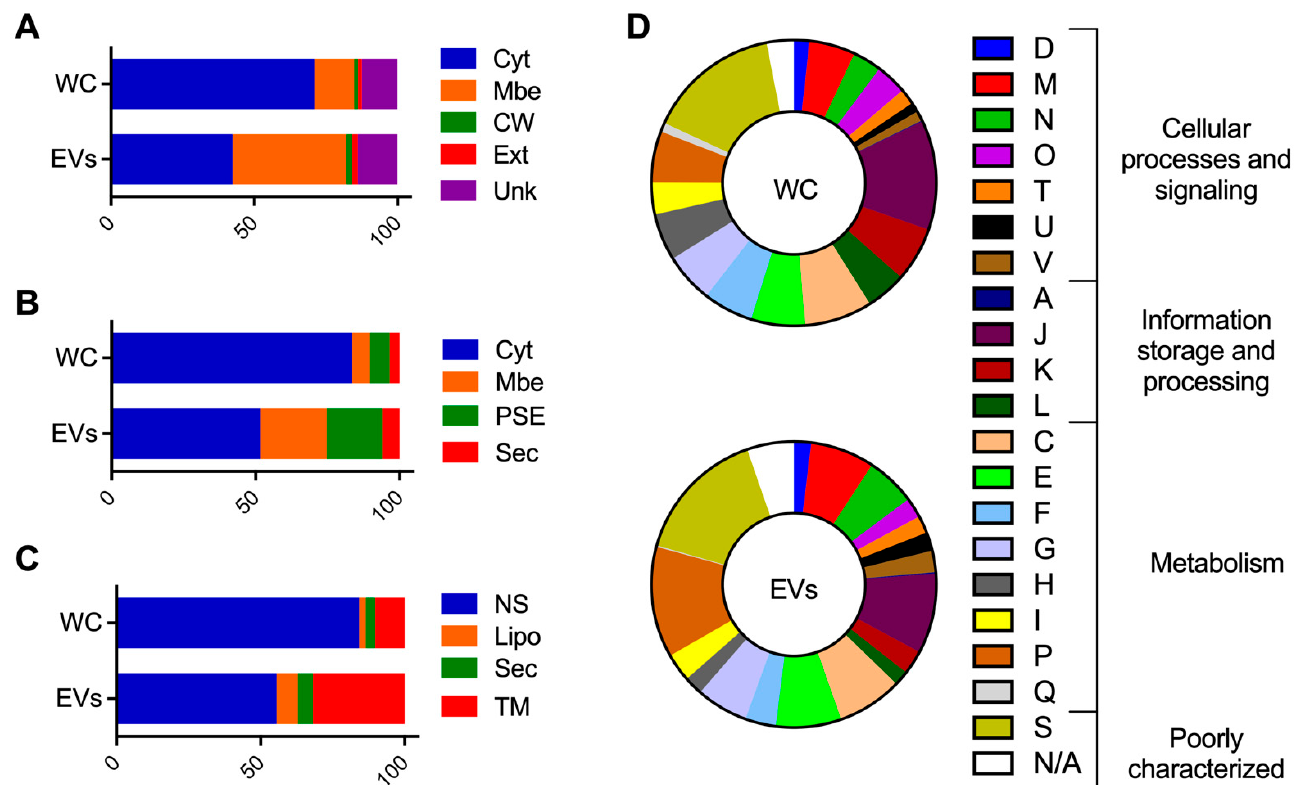
Figure 2. Comparative proteome analysis of S. aureus HG003 WC and EVs. The prediction of subcellular locations of proteins with PSORTb ( A ), SurfG+ ( B ), and PRED-LIPO ( C ), and the prediction of COG functional categories of proteins with eggNOG-mapper ( D ). Cyt, cytoplasmatic; Mbe, Membrane; CW, cell wall; Ext, extracellular; Unk, unknown; PSE, surface-exposed; Sec, secreted; NS, no signals found; Lipo, lipoprotein; TM, transmembrane; COG functional categories: D, Cell cycle control, cell division, chromosome partitioning; M, cell wall/membrane/envelope biogenesis; N, cell motility; O, post-translational modification, protein turnover and chaperones; T, signal transduction mechanisms; U, intracellular trafficking, secretion and vesicular transport; V, defense mechanisms; A, RNA processing and modification; J, translation, ribosomal structure, and biogenesis; K, transcription; L, replication, recombination, and repair; C, energy production, and conversion; E, amino acid transport and metabolism; F, nucleotide transport and metabolism; G, carbohydrate transport and metabolism; H, coenzyme transport and metabolism; I, lipid transport and metabolism; P, inorganic ion transport and metabolism; Q, secondary metabolites biosynthesis, transport, and catabolism; S, function unknown; NA, not